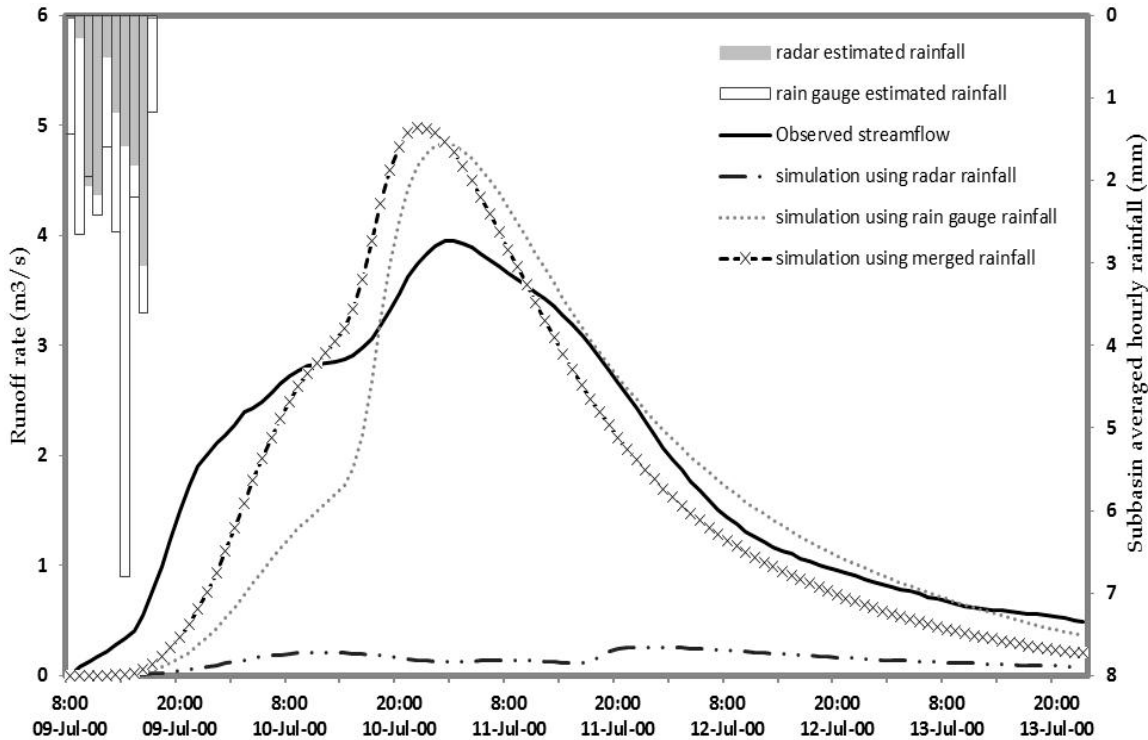
Figure 10. Comparison of estimated and observed hydrographs using different rainfall estimates for the 11 June 2000 event with SCS modeling option.